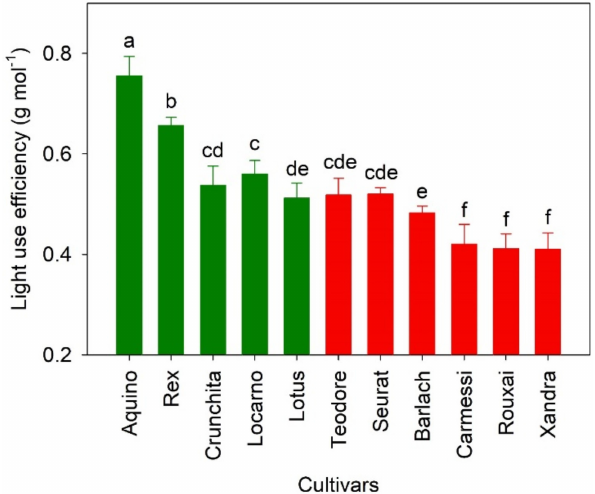
Figure 7. Variation in light use efficiency among the lettuce cultivars. Green and red colored bars correspond to the color of the lettuce cultivars. The error bars indicate standard deviations and letters above these bars represent the result of the mean separation. Cultivars with the same letter are not significantly different from each other ( p = 0.05, n =